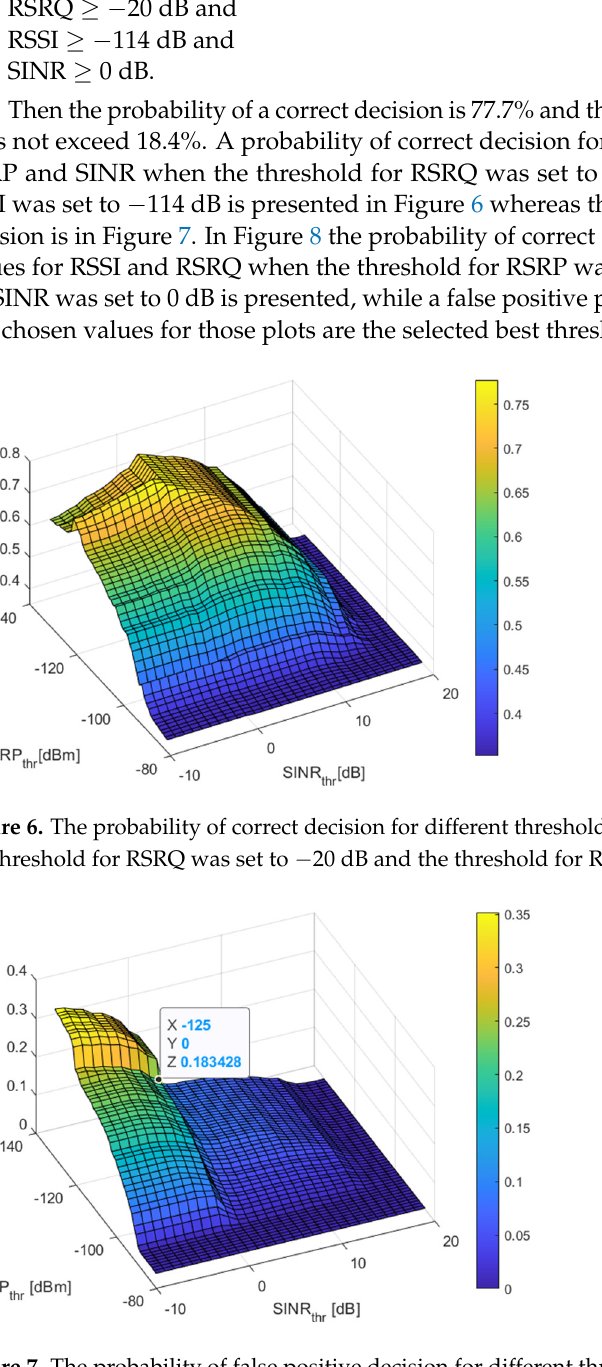
Figure 8. The probability of correct decision for different threshold values for RSSI and RSRQ while the threshold for RSRP was set to −125 dBm and the threshold for SINR was set to 0 dB. Figure 9. The probability of false positive decision for different threshold values for RSSI and RSRQ while the threshold for RSRP was set to −125 dBm and the threshold for SINR was set to 0 dB. 5. Results for LTE